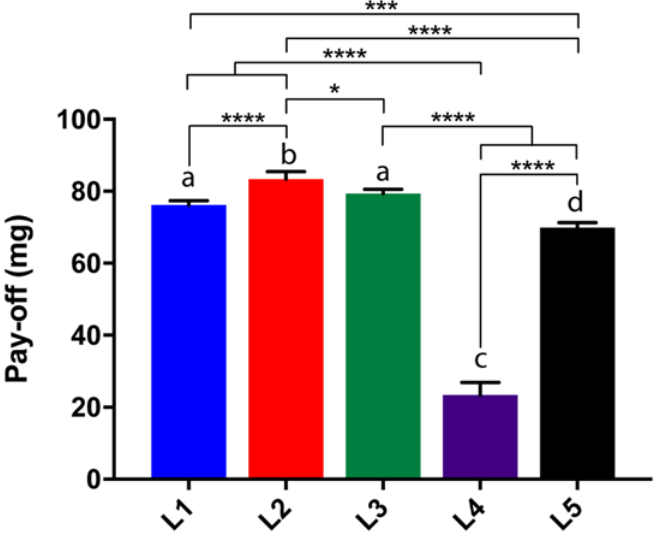
Figure 3. Pay-off to fabric of lipsticks (expressed in mg, mean ± SD, n = 6). An asterisk indicates a statistical difference between formulations. * p < 0.05, *** < 0.001, **** p < 0.0001, One-way ANOVA followed by Tukey’s multiple comparison test. Bars that do not share similar letters denote statistical significance, p < 0.05.